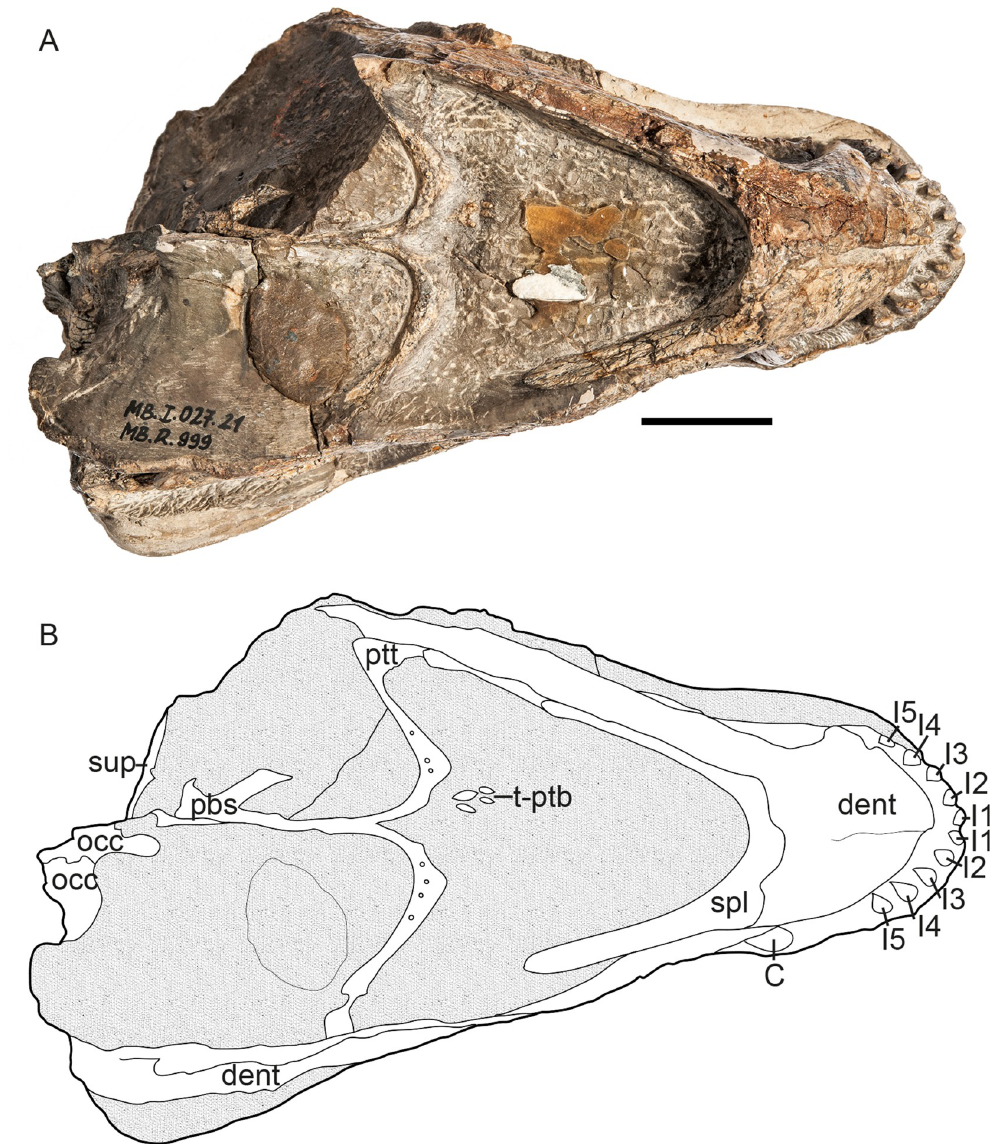
Fig 3. MB.R.999, (A) photograph (reprinted [22] under a CC BY license, with permission from Carola Radke, MfN, original copyright 2016) and (B) interpretative drawing of specimen in ventral view. Abbreviations: C, canine; dt, dentary; I1-I5, incisors 1–5; occ, occiput; pbs, parabasisphenoid; ptt, transverse process of the pterygoid; sup, supraoccipital; t-ptb, teeth on the pterygoidal boss. Scale bar = 2